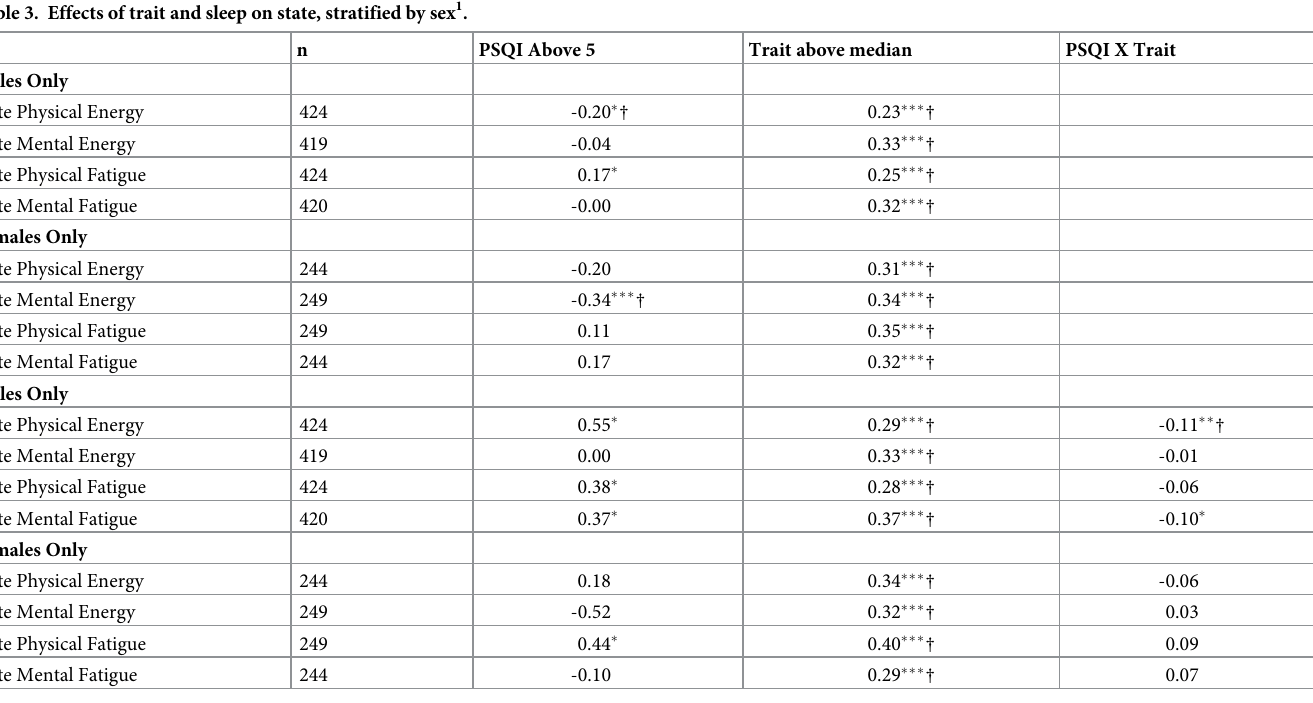
Table 3. Effects of trait and sleep on state, stratified by sex 1 . n PSQI Above 5 Trait above